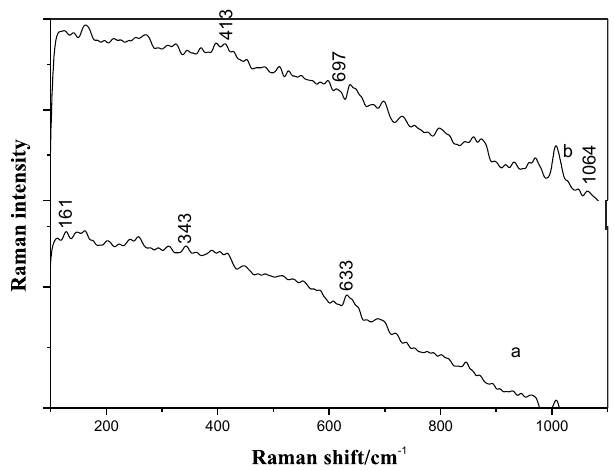
Fig. 4. Raman spectra of several pesticides left on the surface of navel orange (a) Chlorpyrifos; (b) Omethoate.